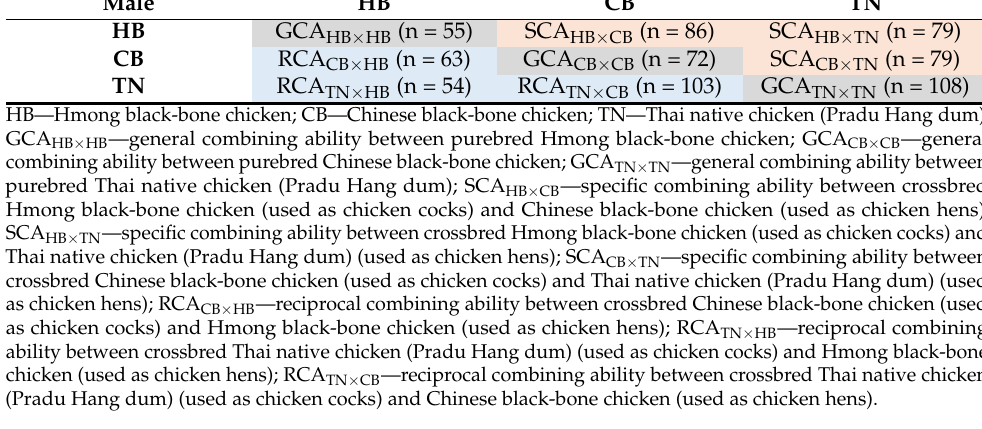
Table 1. The diallel crossing system and number of black-bone chickens, Thai native chickens, and their crossbreeds. Chicken Breed/Sex Female Male